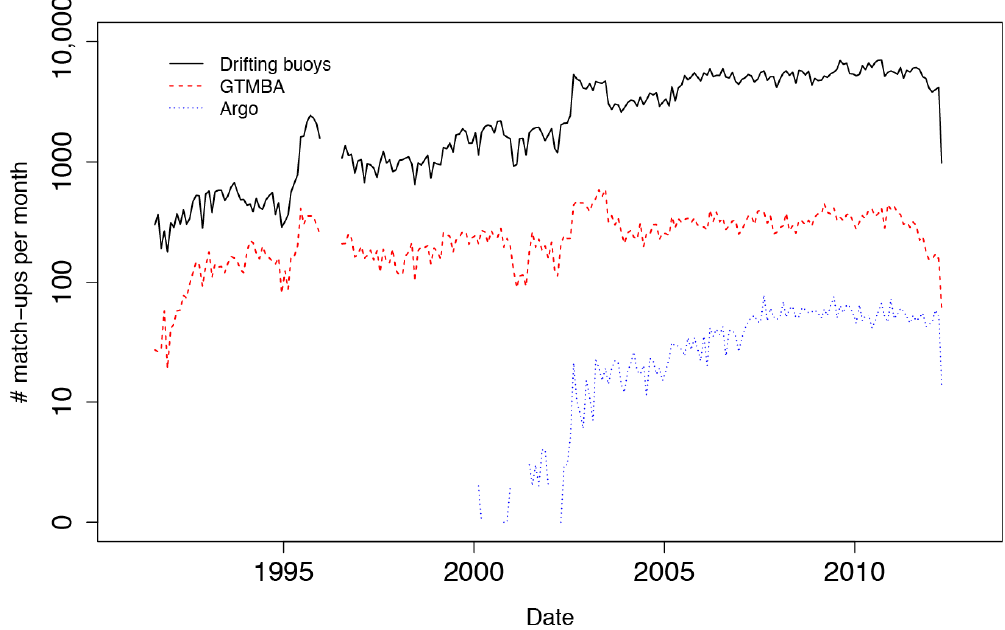
Figure 1. Number of match-ups per month between drifting buoy (black/solid line), GTMBA (red/dashed line) and Argo (blue/dotted line) observations and the ESA SST CCI data meeting the match-up criteria.